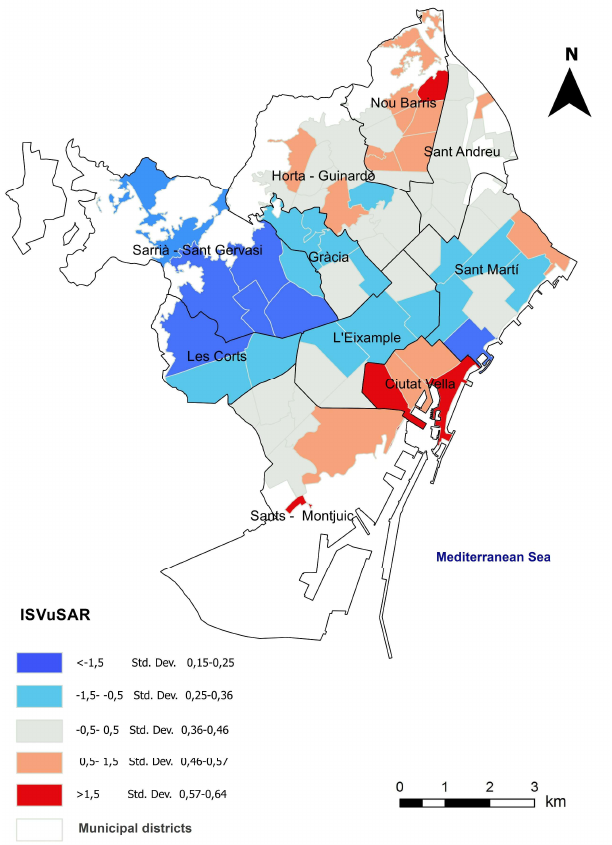
Figure 2. Map of the ISVuSAR results by neighborhood (AUP) of Barcelona. Source: